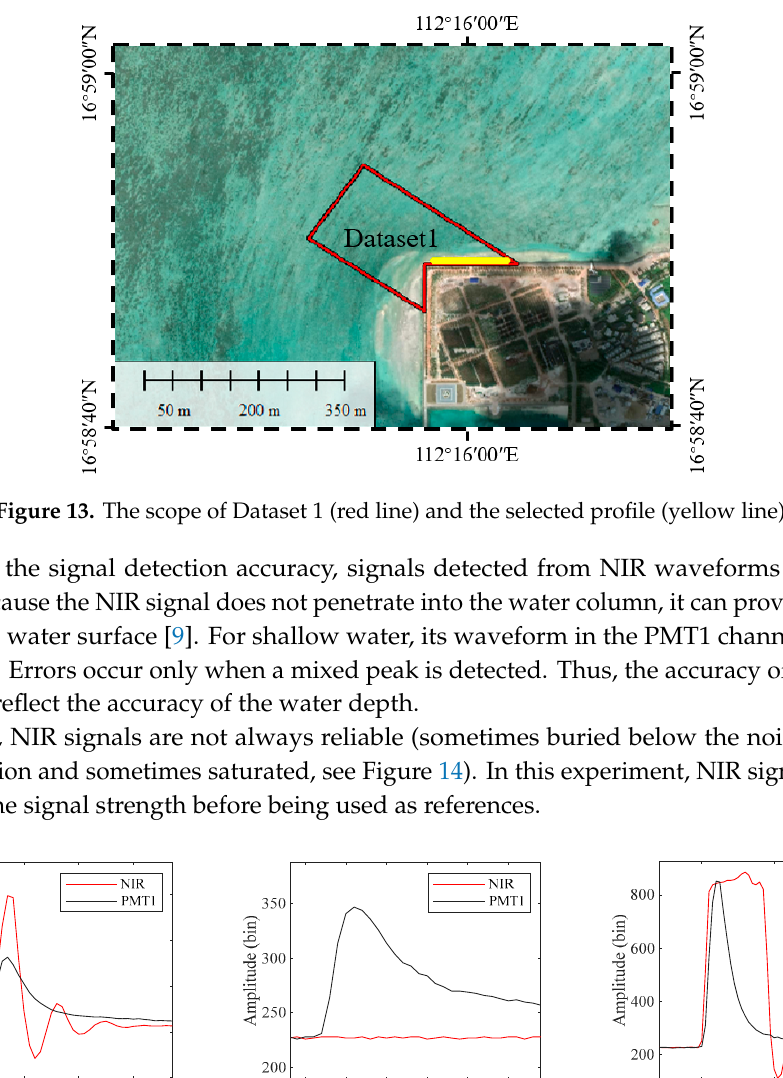
Figure 12. The distribution of S in different cases.